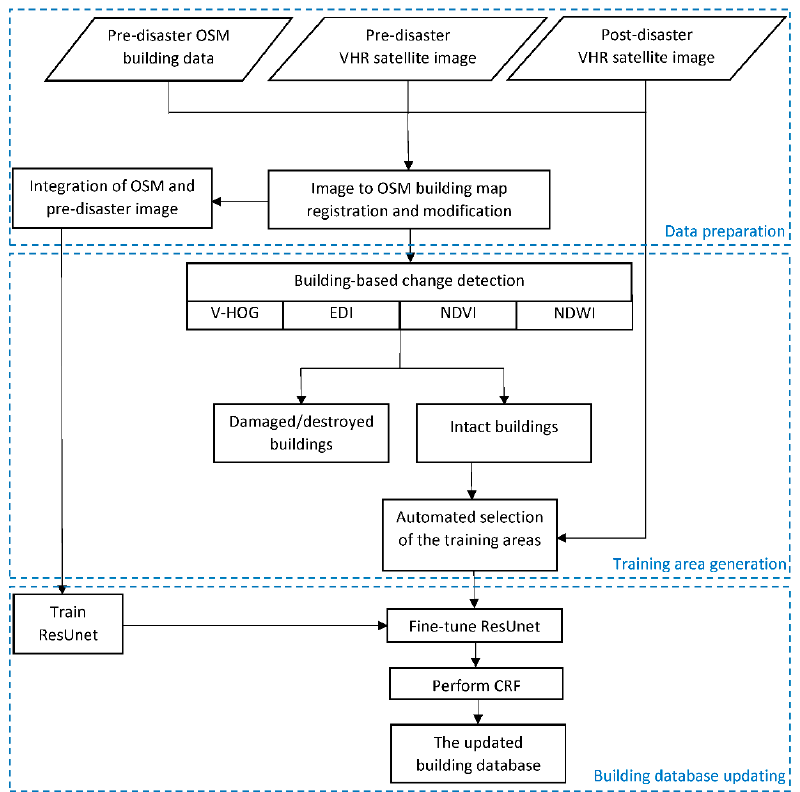
Figure 1. The framework proposed in this paper for post-disaster building database updating. Notes: V-HOG = Variation of Histogram of Oriented Gradients; EDI = Edge Density Index; CRF = Conditional Random Field.